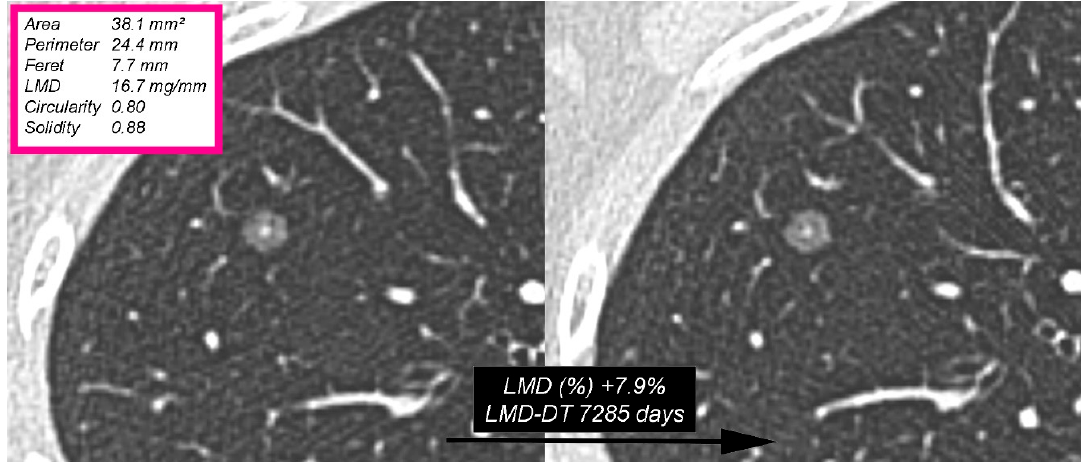
Figure 5. Nongrowing part-solid nodule (PSN) in the right upper lobe in a 43-year-old woman (nonsmoker and without an oncologic history). The PSN exhibits a rounded shape. The interval between the baseline ( left ) and last follow-up CT scan ( right ) was 789 days. The computerized analysis showed a relative linear mass density (LMD) variation of +7.9% in the nodule (less than the cut-off of 11.3%) with a LMD-doubling time (LMD-DT) of 7285 days. The purple box (top left) shows the main quantitative features obtained from the baseline CT image.